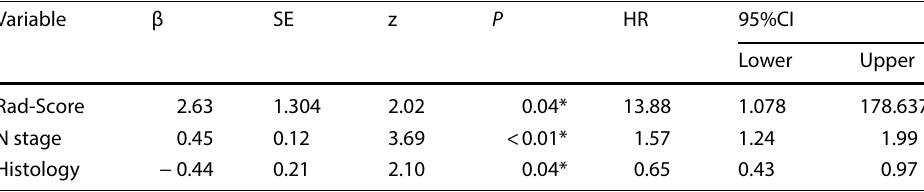
Table 4 Multivariable Cox regression analysis of risk factors of disease progression in the training